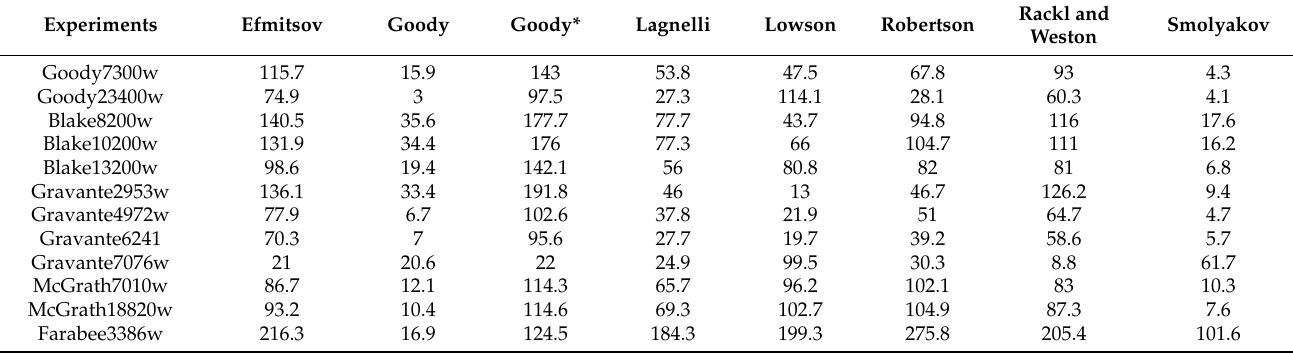
Table A3. Spectrum mean squared